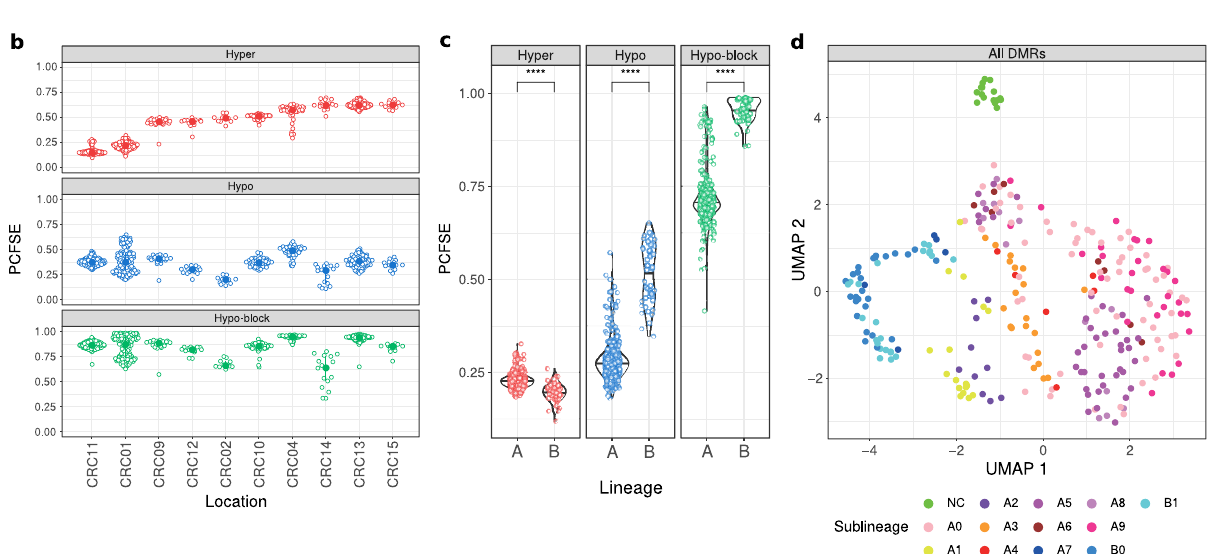
Fig. 5 Application of DMR catalog to single cell DNA methylation from colorectal cancer samples. a Heatmap of DMRs beta values in scTRIO cohort. 50 randomly selected regions for each class are depicted. For the dendrogram, hierarchical clustering using 1 - Pearson ’ s correlation was applied to all cells having less than 10% of DMRs with missing values (NC: normal colon, TP: tumor primary). b Per Cell Fraction of Supporting Events (PCFSE) for each DMR class among the different patients. Only cells that had less than 50% of missing values within DMRs across each one of the DMR classes were considered. Patients are sorted based on PCFSE of Hyper DMRs. c Difference in PCFSE in lineage A and lineage B in CRC01 cells for each class of DMRs. Signi fi cance is evaluated using two tailed Wilcoxon test. d UMAP dimensionality reduction for cells from CRC01, using the beta value in all DMRs as input (missing values were imputed using